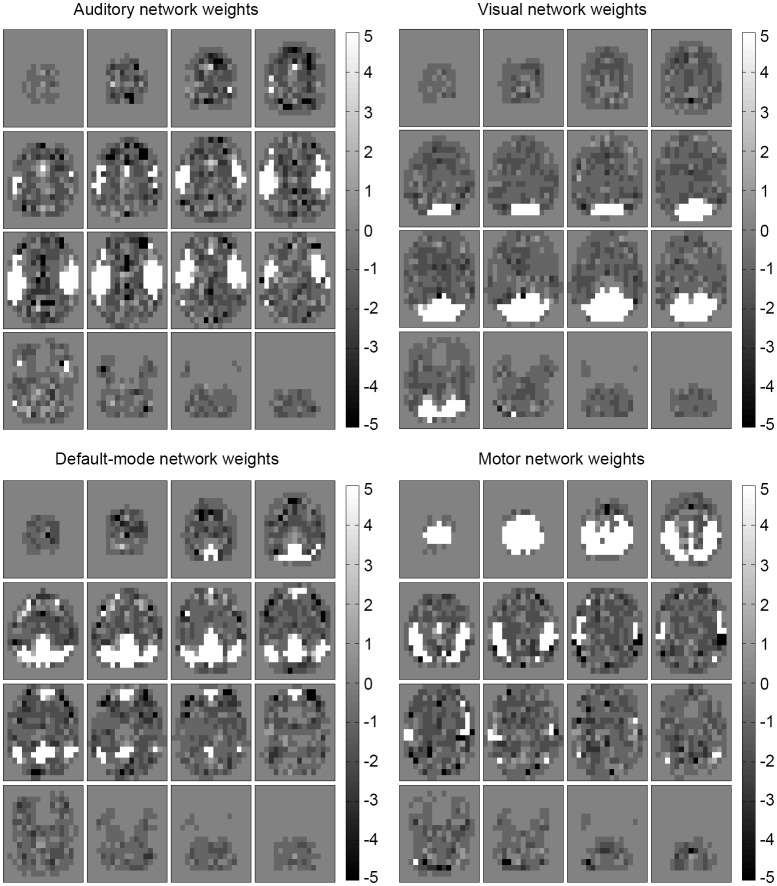
Influential features and areas for naïve Bayes. Most likely values (learned conditional probabilities) for the naïve Bayes classifier (epilepsy) are shown for each predicted network (executive control not shown). The most influential areas correspond anatomically to their respective network location. Note that the values were shifted to be centered at zero (from the original [1,11] range) to match the perceptron weight appearance.